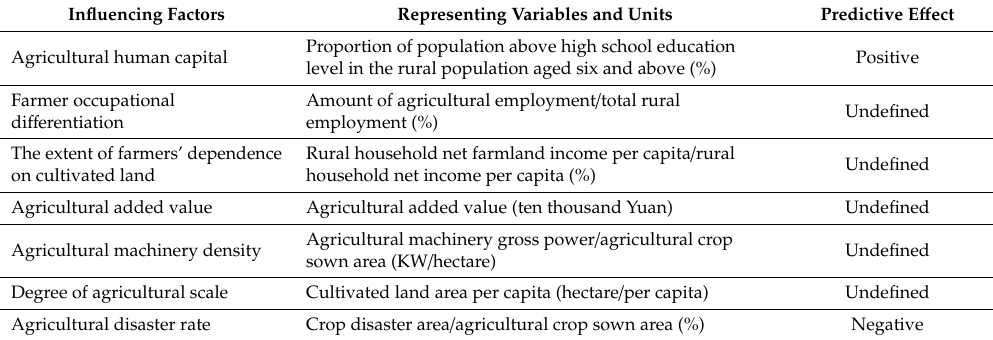
Table 2. Influencing factors of the